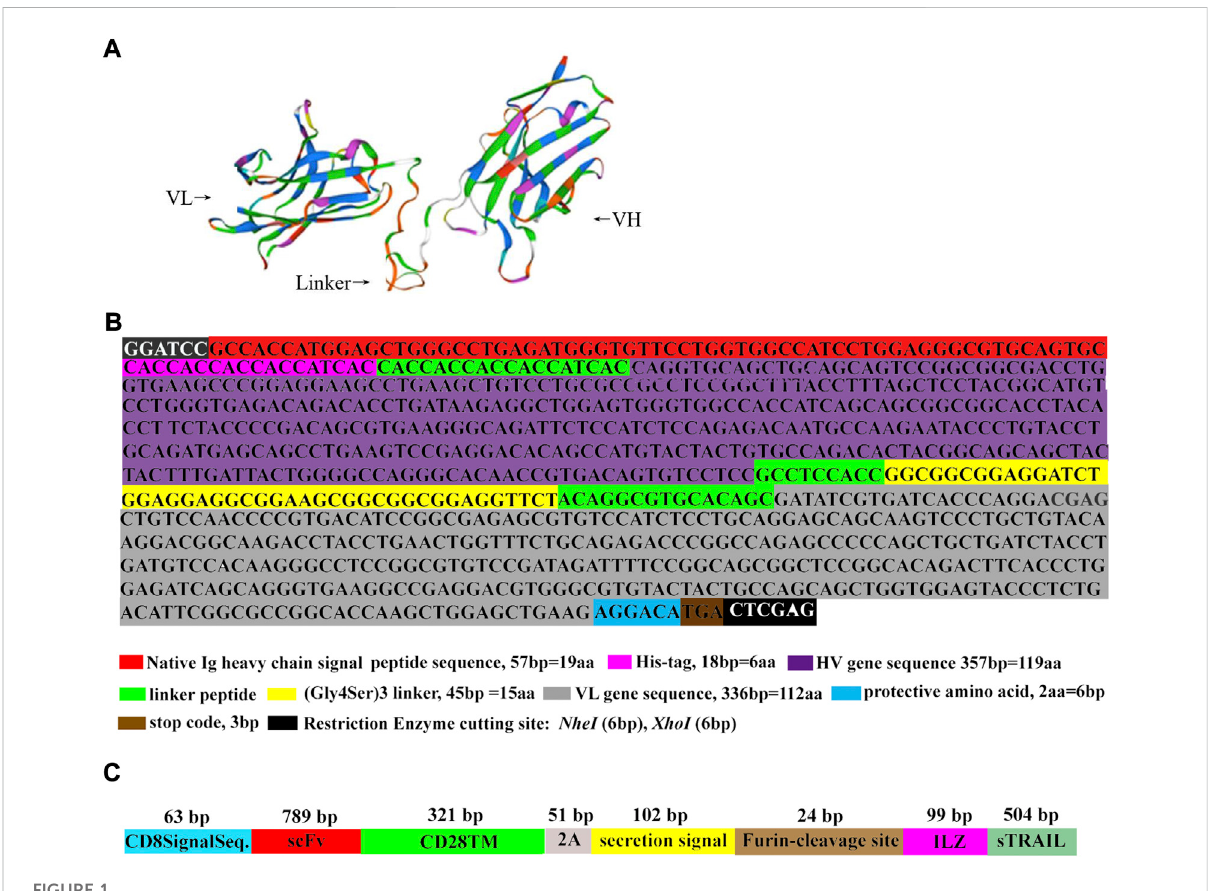
FIGURE 1 The schematic diagram of scFv and scFv-sTRAIL. (A) The mimic tertiary structure of scFv protein. (B) The results of scFv sequence determination. (C) The gene linear structural pattern diagram of the sequence encoding scFv-sTRAIL fusion